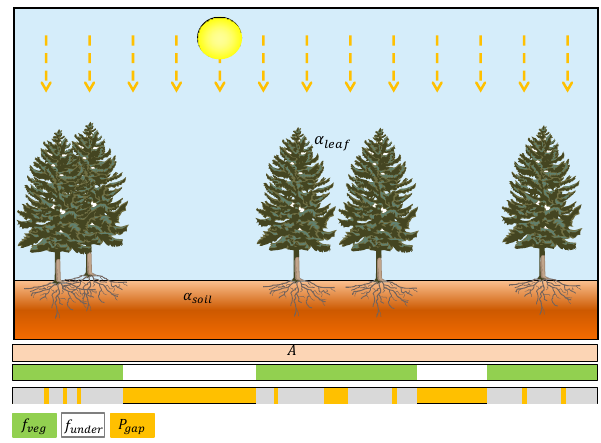
Fig. 1. Illustration of the difference between vegetation fraction ( f veg ) and gap probability ( P gap (θ = 0)) for a model grid cell that is assumed to be totally